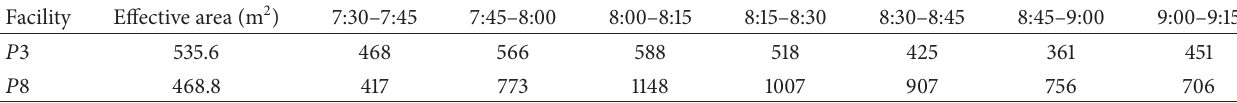
Table 3: Passenger volumes at the platforms.